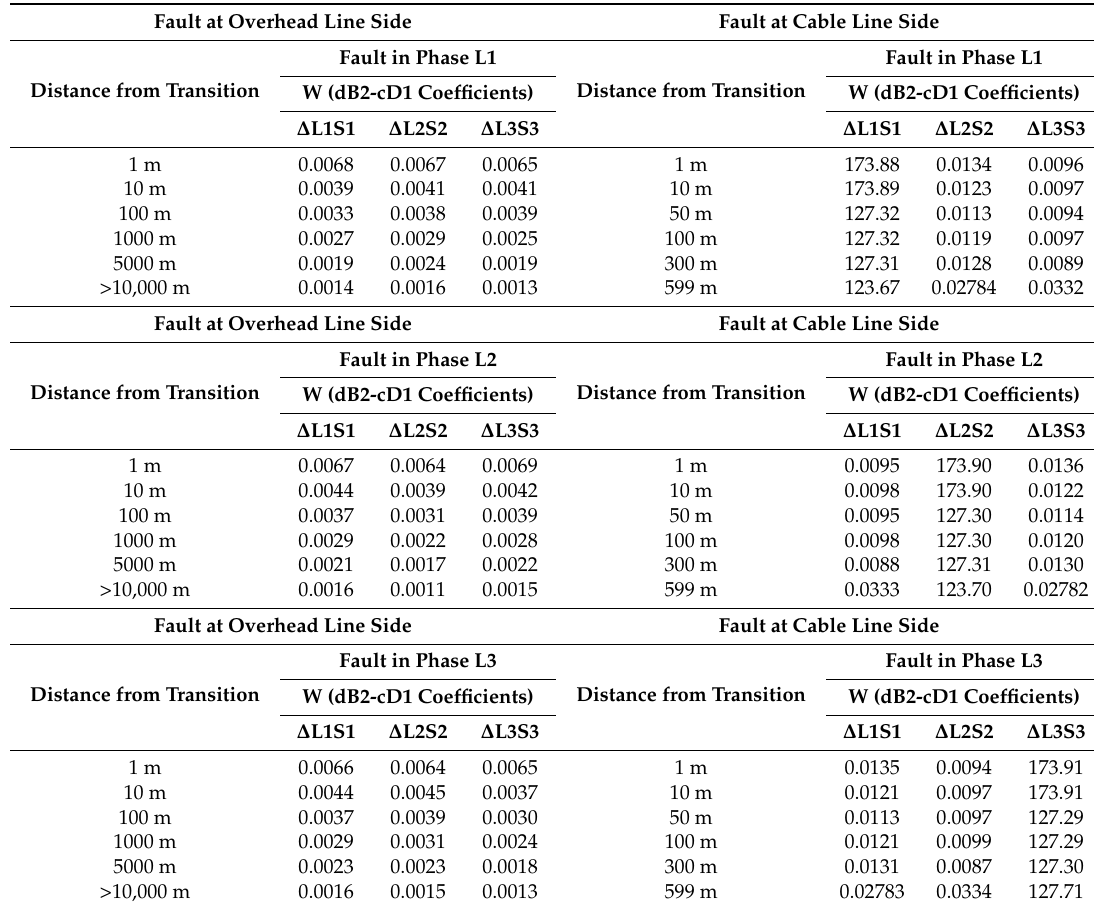
Figure 13. Wavelet dB2-1-cD1 coefficients of the angular difference signals with ground fault in phase L1 at the cable line side 300 m from the transition. Table 2. Wavelet analysis: simulation results. Ground faults at the overhead and cable line sides. Overhead line side solidly grounded and cable line side isolated. Phase currents measured in the conductors (L1, L2, L3) and in their shields (S1, S2, S3).